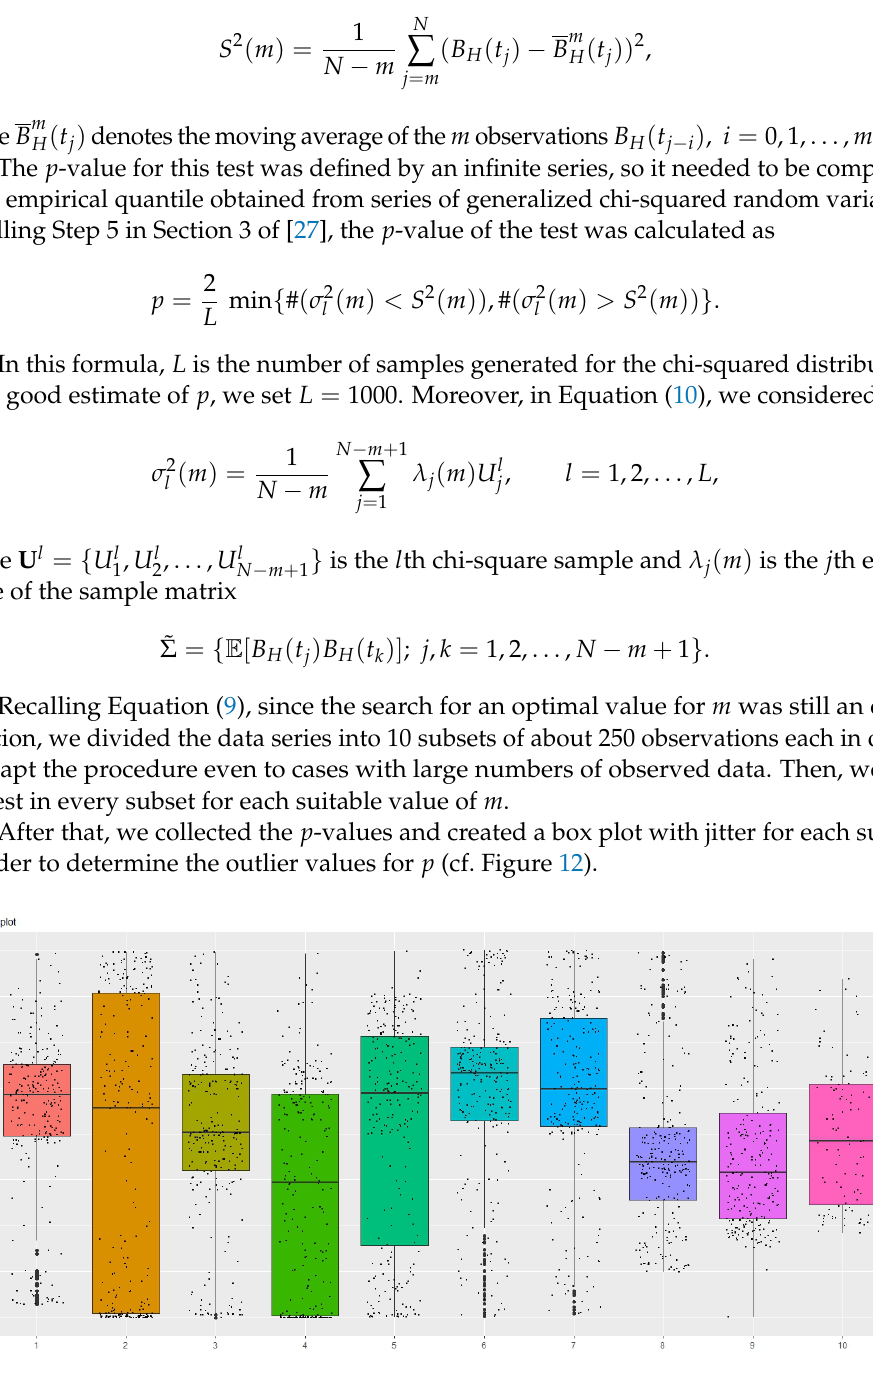
Figure 12. Box plot for the values of p obtained in the 10 subsets of the